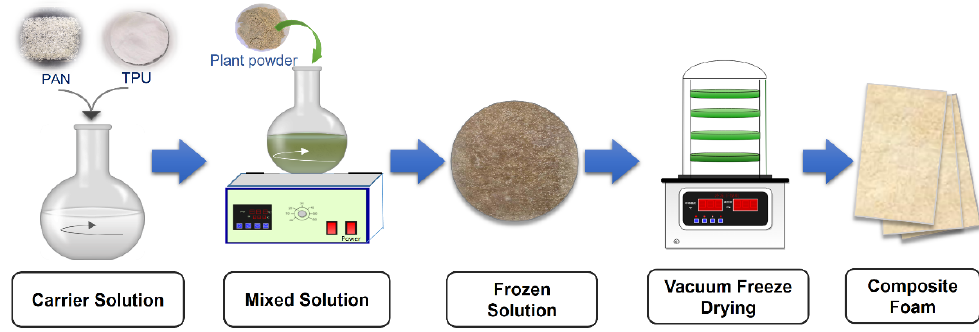
Figure 1. Preparation of the composite foams.